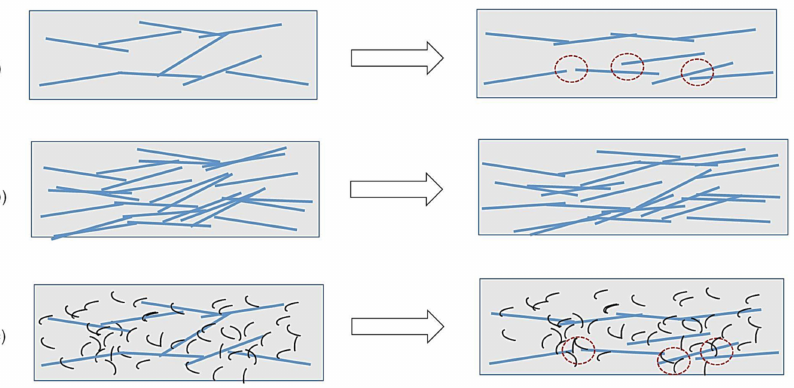
Figure 14. Change in the electorally conductive network under tensile deformation of ( a ) 0.25% CF, ( b ) 0.75% CF and ( c ) 0.25% CF with